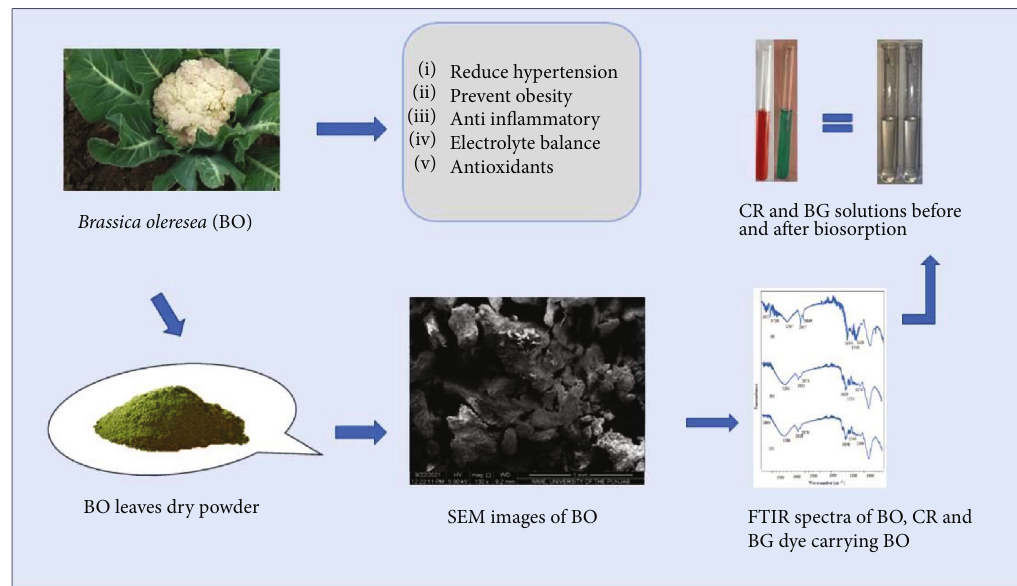
Figure 8: Summarizing whole work in one